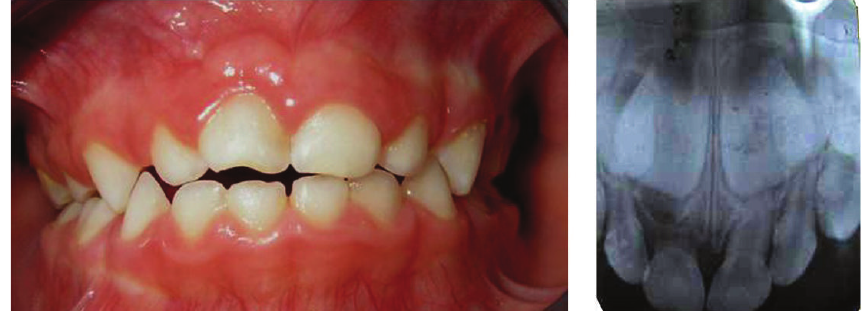
Figure 2: Examination 3 months after the trauma.